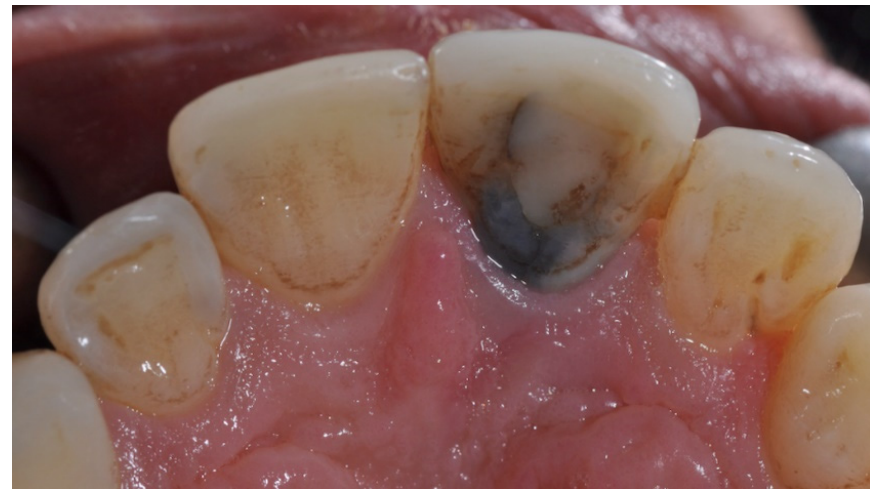
Figure 3. Preclinical intraoral picture, after the second trauma, frontal view.